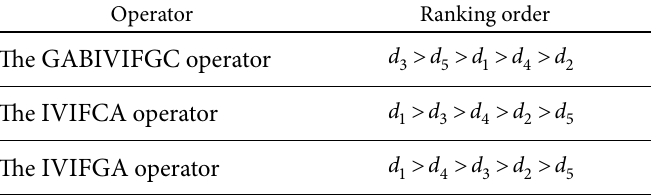
Table 2. Ranking results with respect to the different aggregation operators Operator Ranking